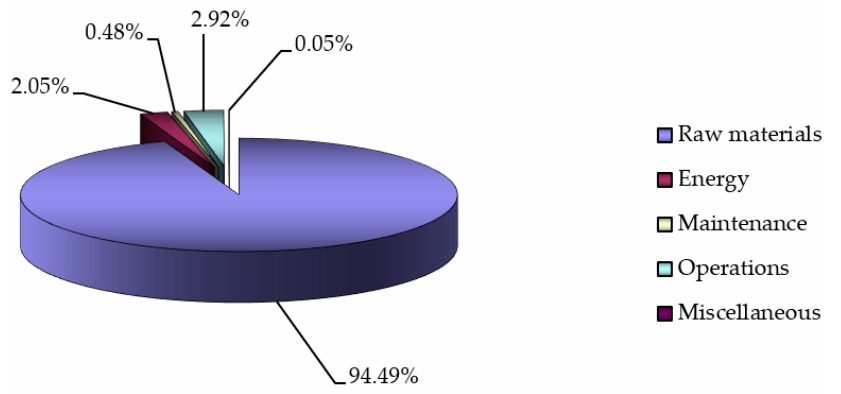
Figure 1. Structure of costs in a modern oil refinery.